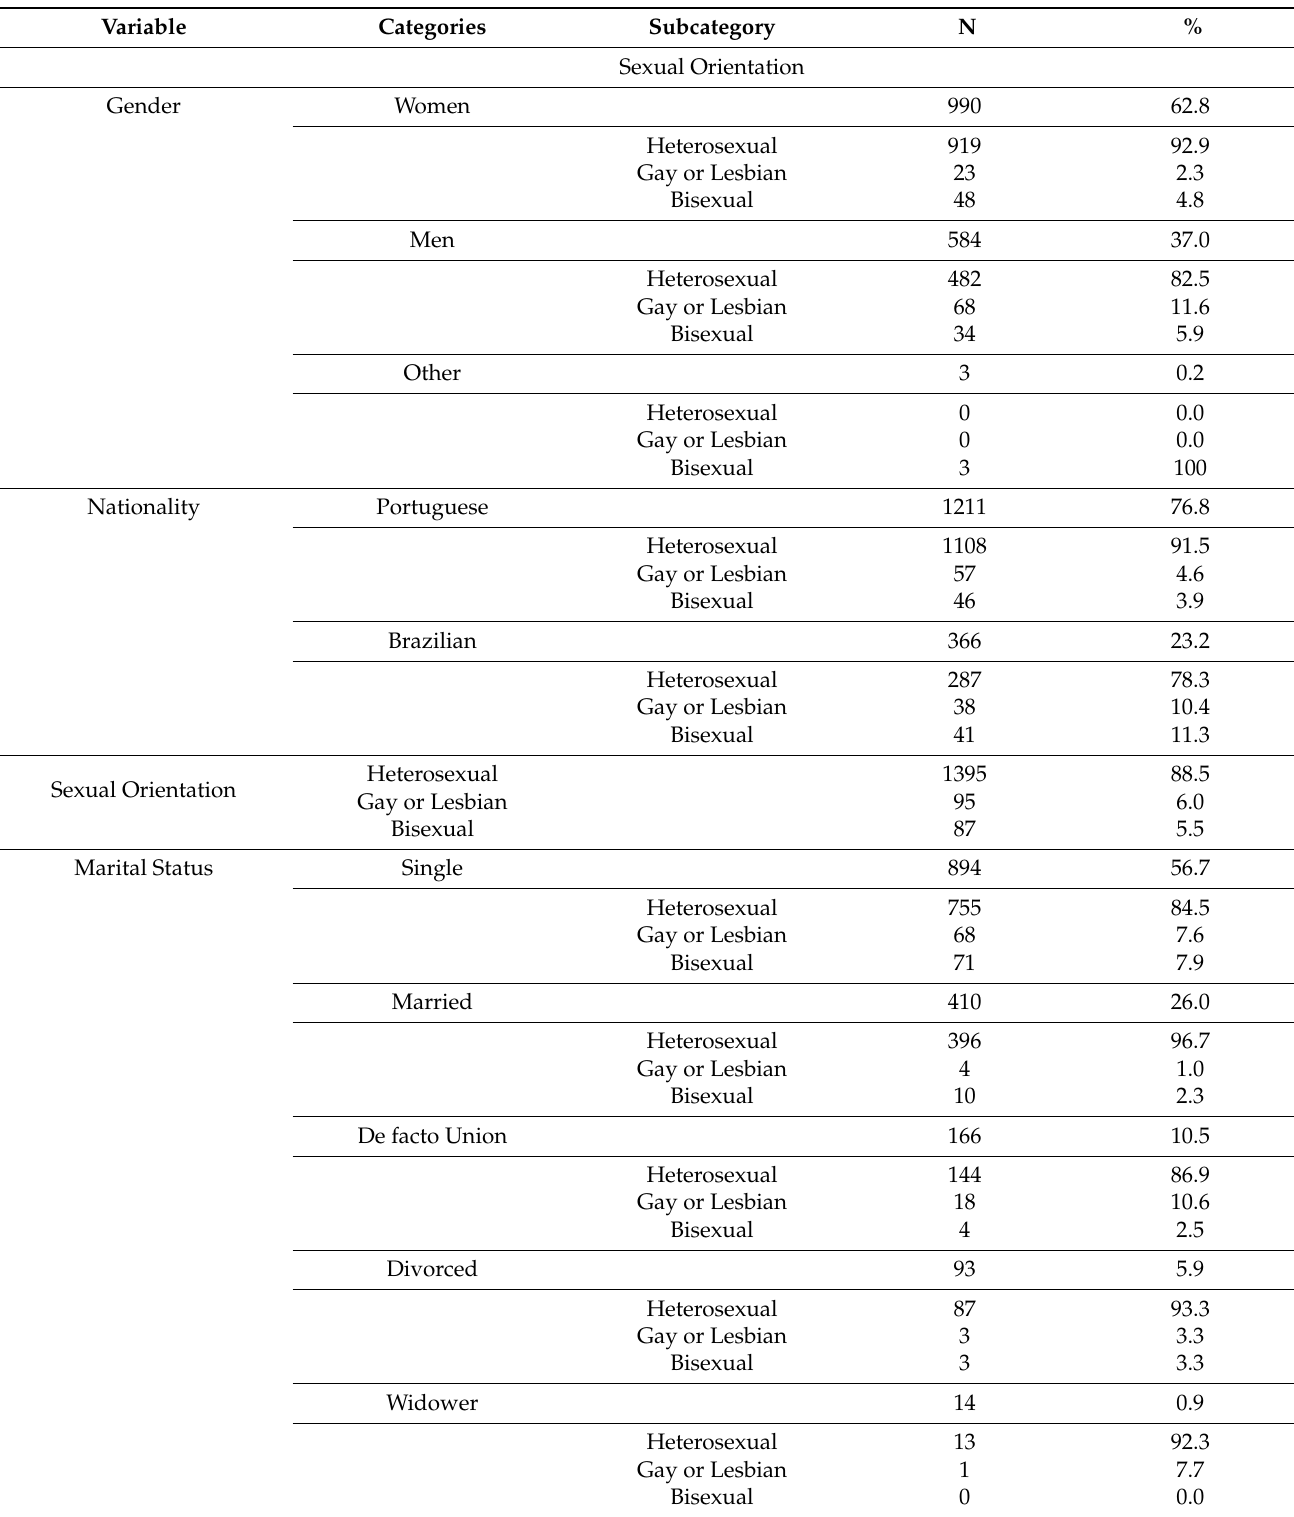
Table 1. Sociodemographic Characteristics by Sexual Orientation (N = 1577, M age = 33.70, SD = 12.97).